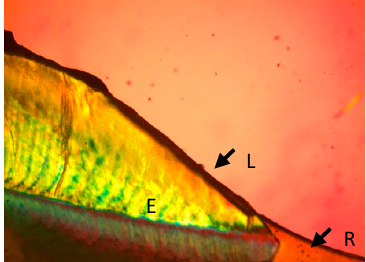
Figure 4. Tetric Evoceram Bulk Fill in enamel at 10 times magnification (E—enamel, L—lesion, R— restoration).